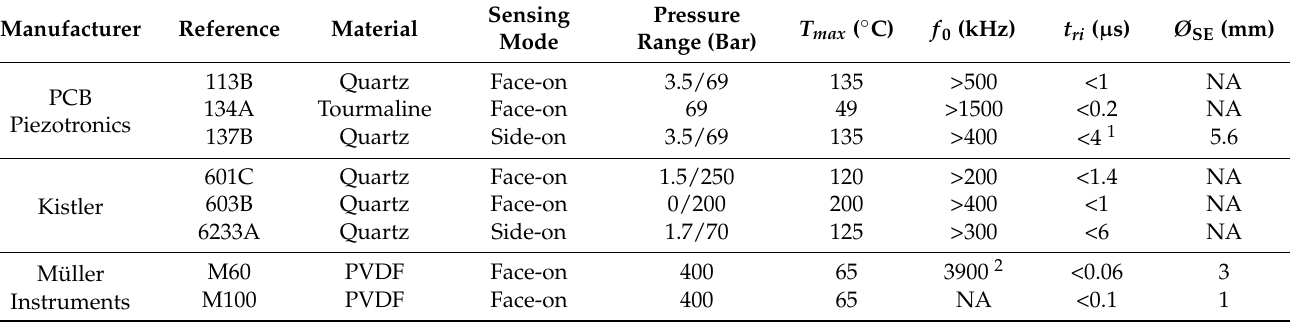
Table 1. Performances (from datasheets provided by manufacturers) of commercial sensors dedicated to air blast monitoring ( T max is the maximal operating temperature, f 0 is the resonant frequency, t ri is the sensor rise time; Ø SE is the diameter of the sensing element. Face-on and side-on modes correspond to the cases where the blast wave direction is normal and tangential to the surface of the sensors, respectively. NA stands for “not available data” ).